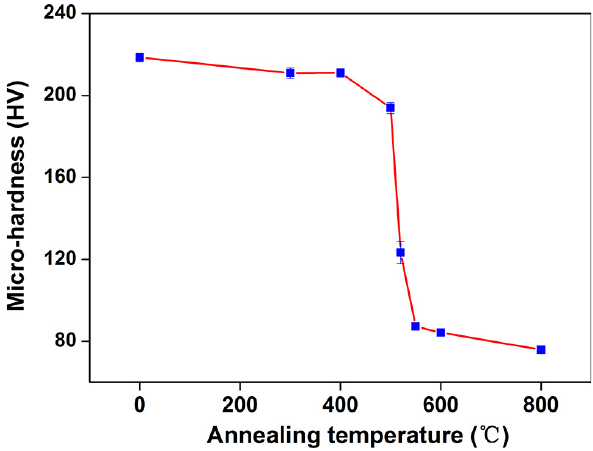
Figure 5: Micro-hardness evolution for CCR samples subjected to annealing at 0-800 ∘ C for 1